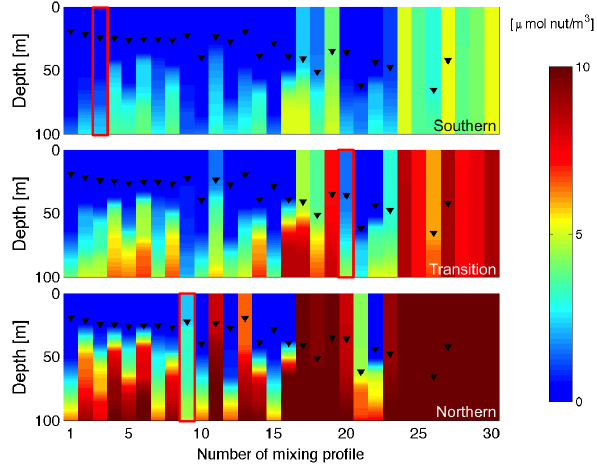
Figure 11. Nutrient concentration results of the sensitivity study based on the vertical mixing shown in Fig. 9 and the three reference Fig. 11: Nutrient concentration results of the sensitivity study stations: southern, transition and northern (top to bottom). The red based on the vertical mixing shown in Fig 9 and the three boxes show the respective reference reference stations: southern, transition and northern (top to bottom). The red boxes show the according reference state.